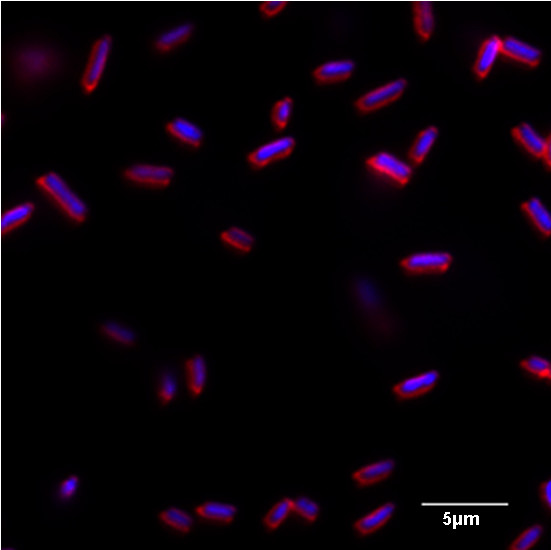
An epifluorescence image of E. coli K12 strain AB1157.